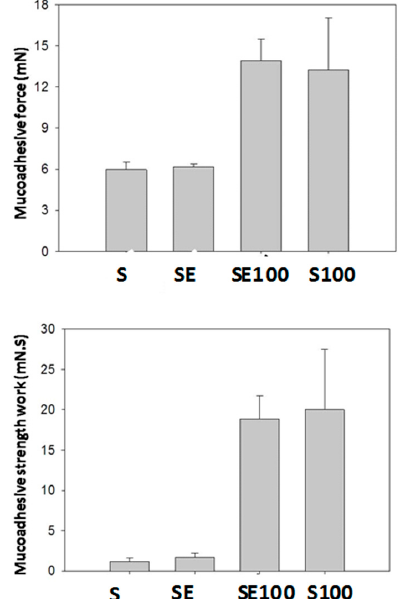
Figure 4. Parameters of in vitro bioadhesion test of all formulations. Each value represents the mean (±SD) of at least seven replicates. Legend: S = Formulation; SE = Formulation with extract; S100 = Formulation + 100% of AVM; SE100 = Formulation with extract + 100% of AVM.